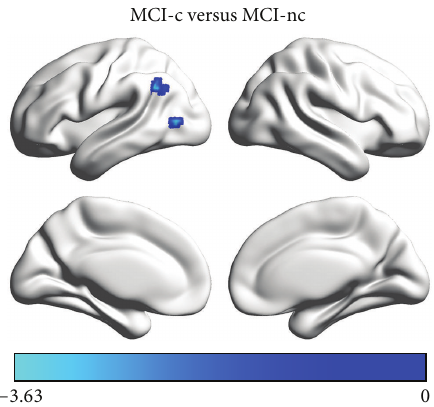
Figure 2: The FCS differences between MCI-c and MCI-nc